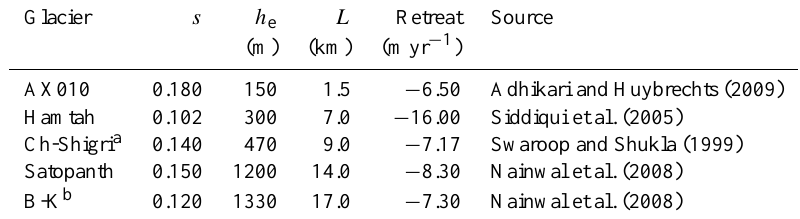
Table 1. Observed values of slope, h e = h max − h ELA and length for a few Himalayan glaciers. Glacier Retreat